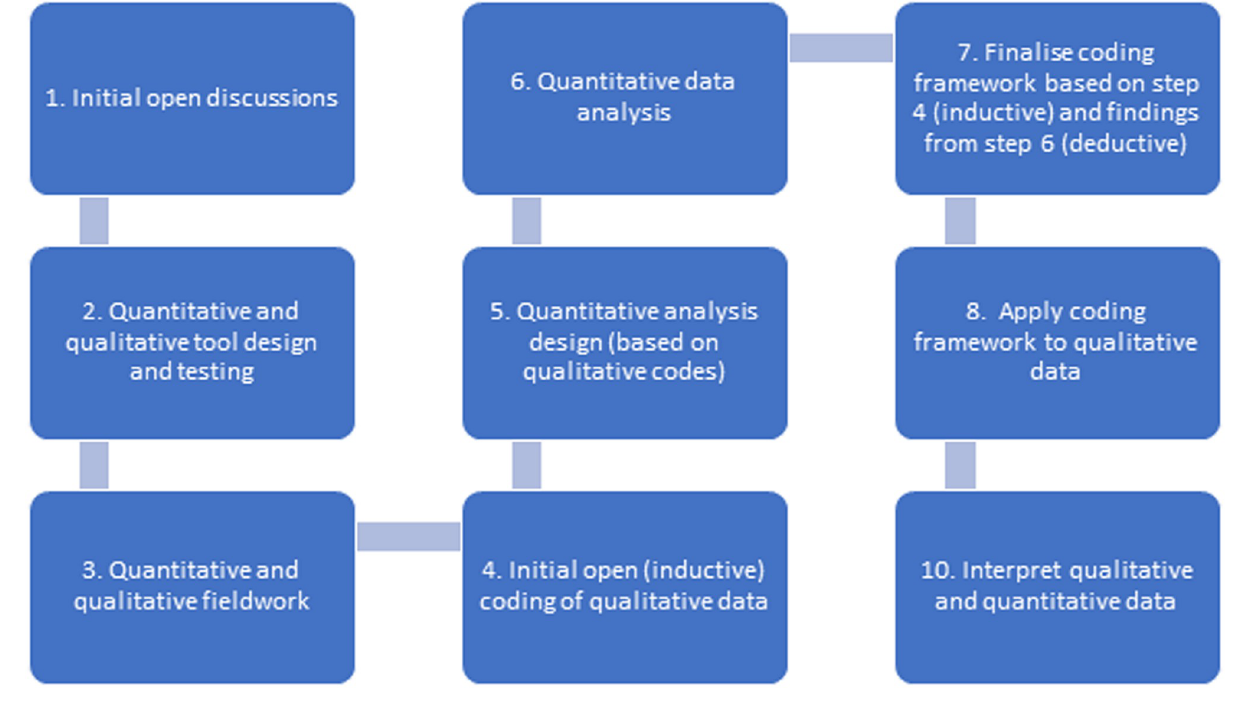
Fig 3. Schematic of study